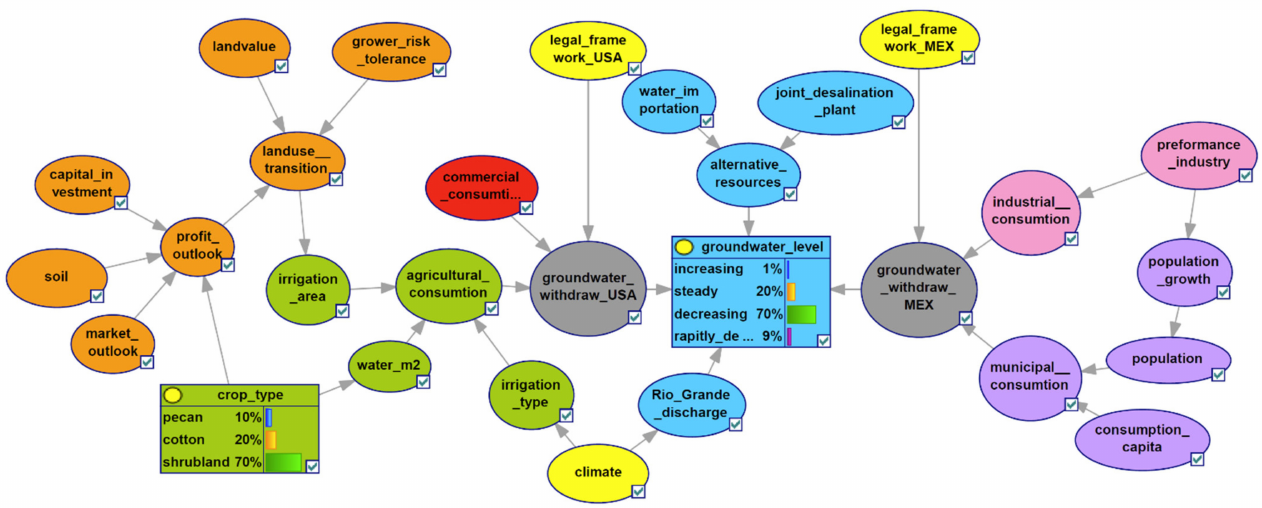
Figure 7. Simplified Bayesian belief network for a transboundary aquifer. Each variable is represented by one node and has an accompanying conditional probability